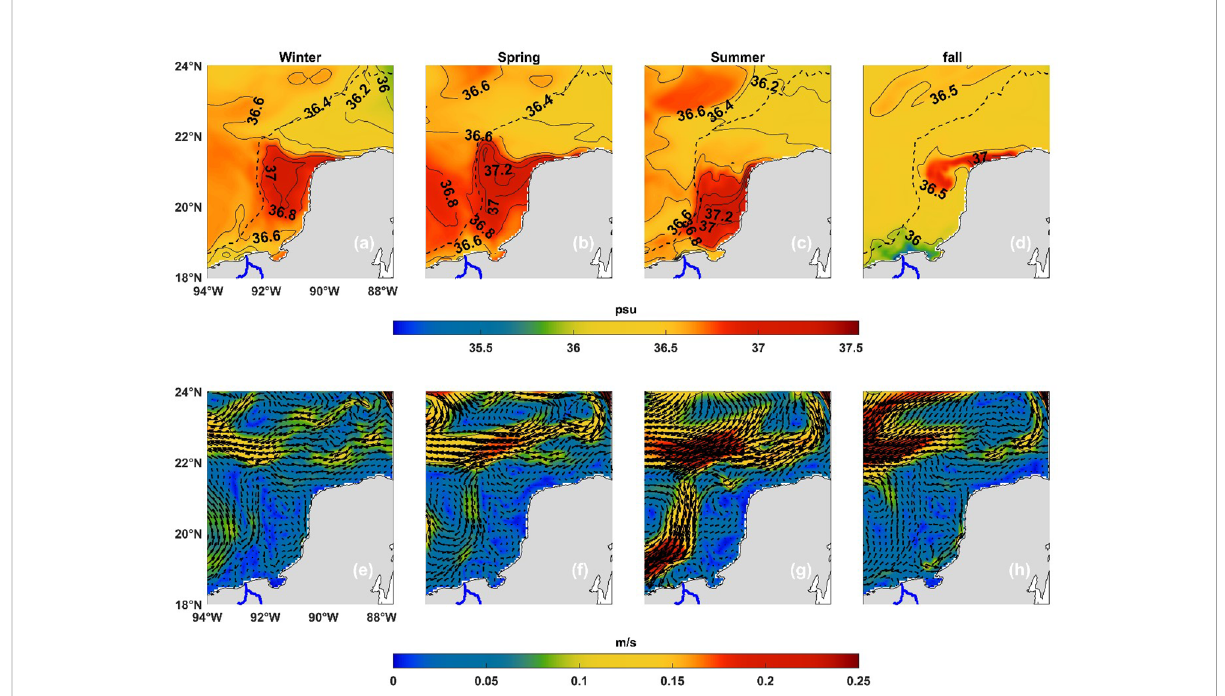
FIGURE 9 Seasonal surface maps of Salinity (A – D) and Circulation (E – H) in the eastern platform of Yucatan from the CROCO hydrodynamic